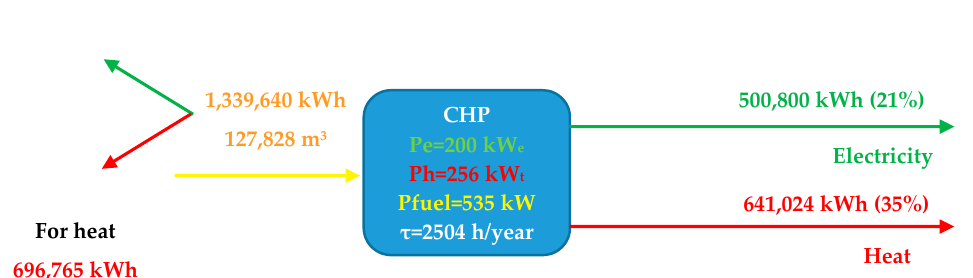
Figure 20. Cogeneration (1 × 200 kW e , 1 × 256 kW t ). Table 4. Cogeneration (1 × 200 kW e , 1 × 256 kW t ): summary results.